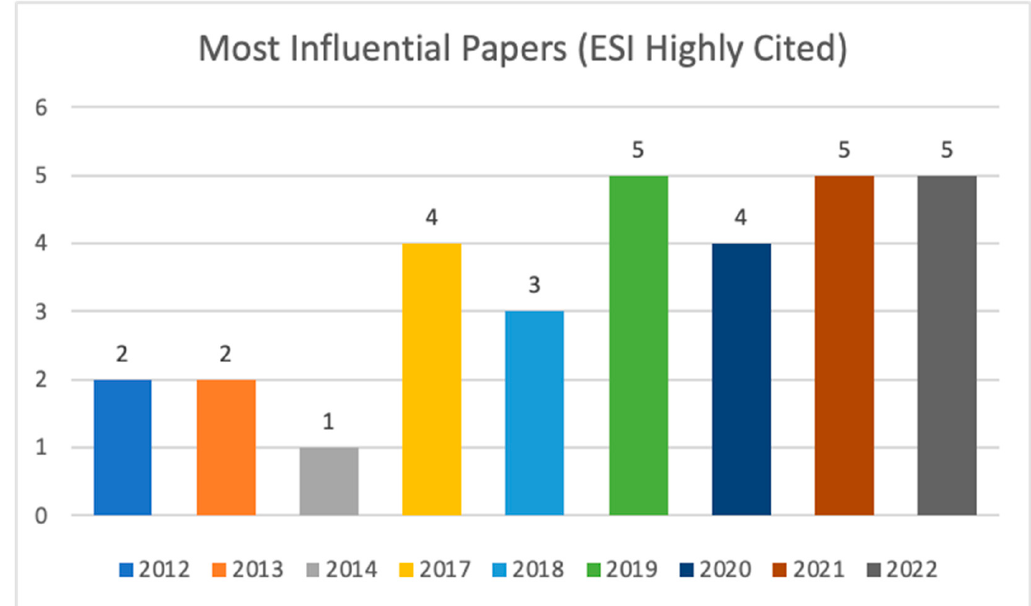
Figure 2. Number of articles versus publication year of most influential articles.